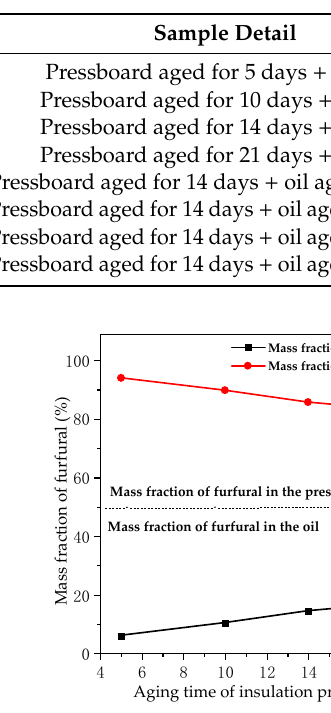
Table 4. Formation of the eight special sample groups.